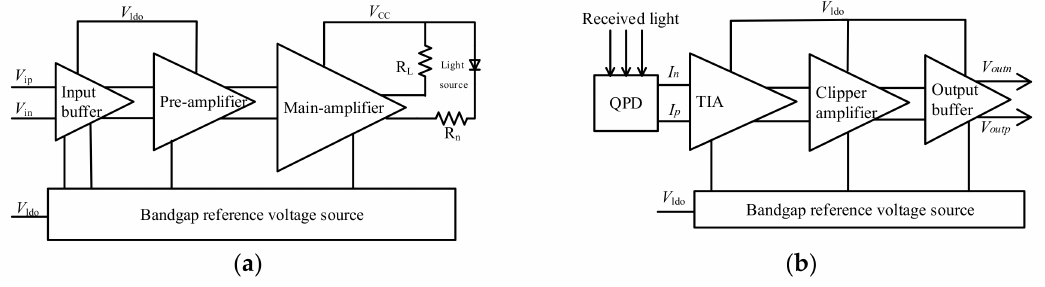
Figure 8. The block diagrams of the driving circuits; ( a ) The driving circuits. ( b ) The receiving circuits.